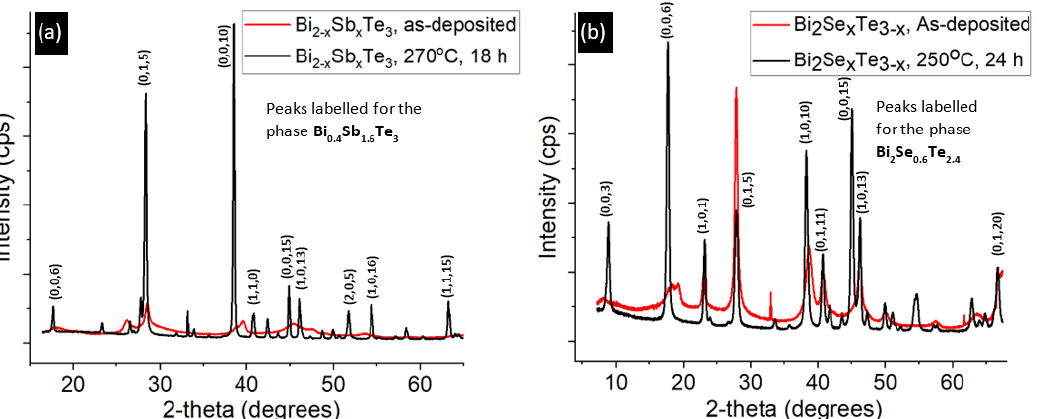
Figure 3. XRD data before and after post-deposition annealing. ( a ) P − type thin film sample demon- strates that baking at 270 °C for 18 h is essential for improving the crystallinity of the as − deposited film. ( b ) A similar change in crystallinity was observed on an n-type sample baked at 250 °C for 24 h.